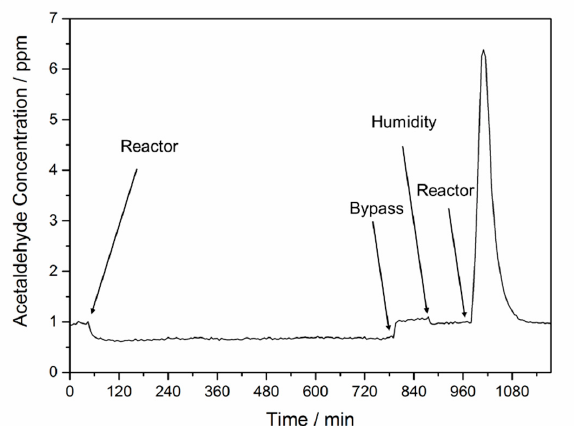
Figure 5. The concentration of acetaldehyde as a function of time obtained in the dark. Firstly, an anatase film was treated with acetaldehyde, under dry conditions. A decrease in the concentration of acetaldehyde was observed when the gas flow was directed into the reactor. Under humidified conditions, the concentration of acetaldehyde detected at the gas outlet increased to 6 ppm, before it decreased to the initial value of 1 ppm again.